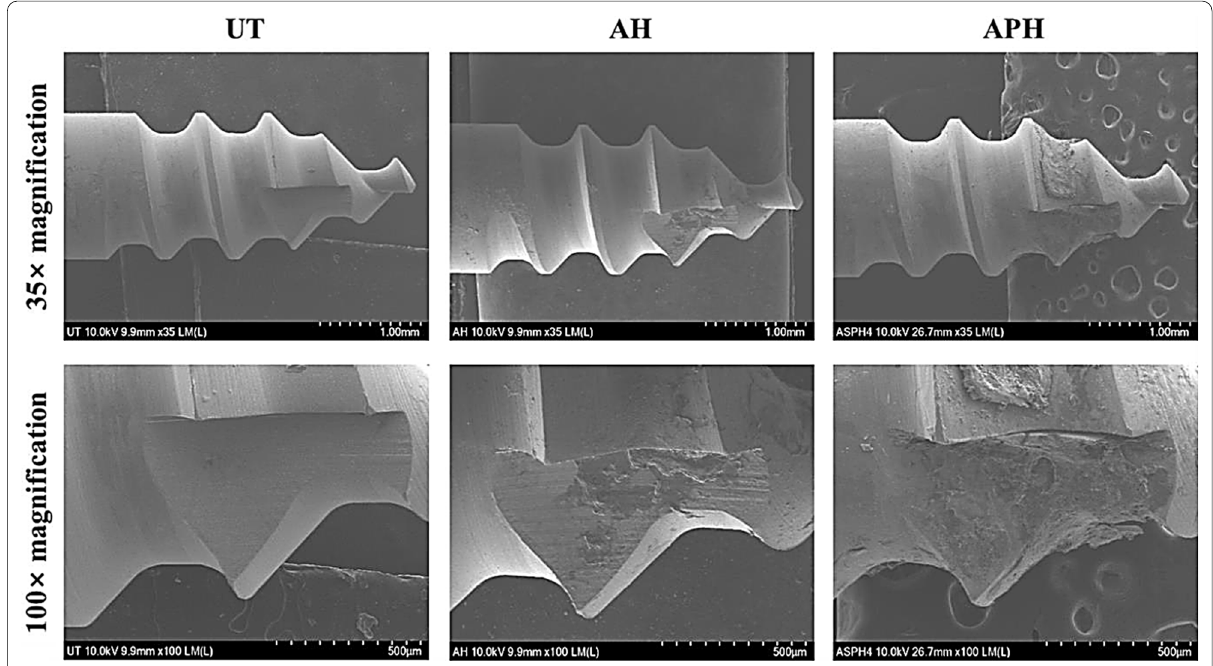
Fig. 9 FE‑SEM images of the UT, AH, and APH group mini‑screws removed 4 weeks after implantation into rabbit tibias